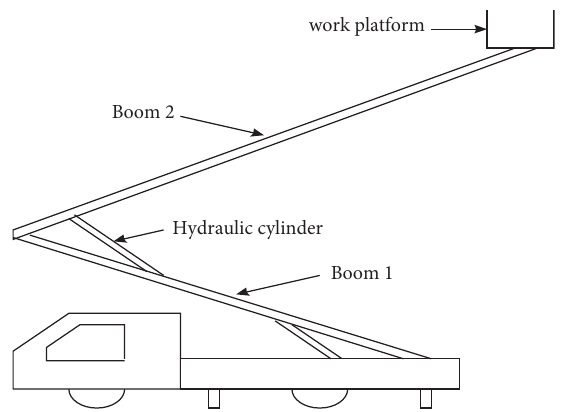
Figure 1: Scheme of folding-boom aerial platform